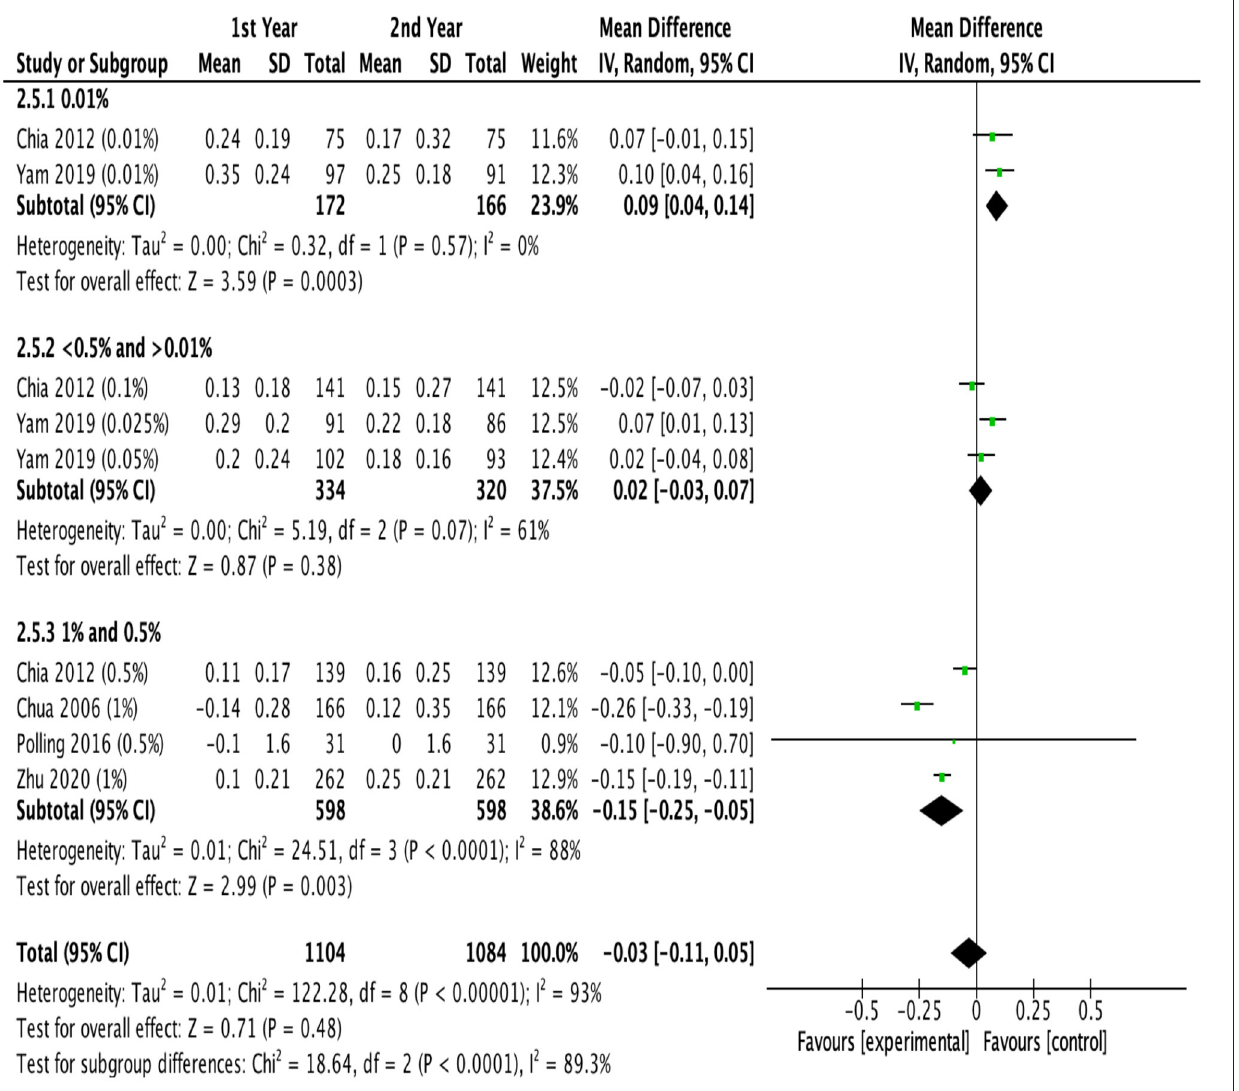
FIGURE 6 | Effects of different doses of atropine on axial elongation in the first and second years of treatment (mm/year).